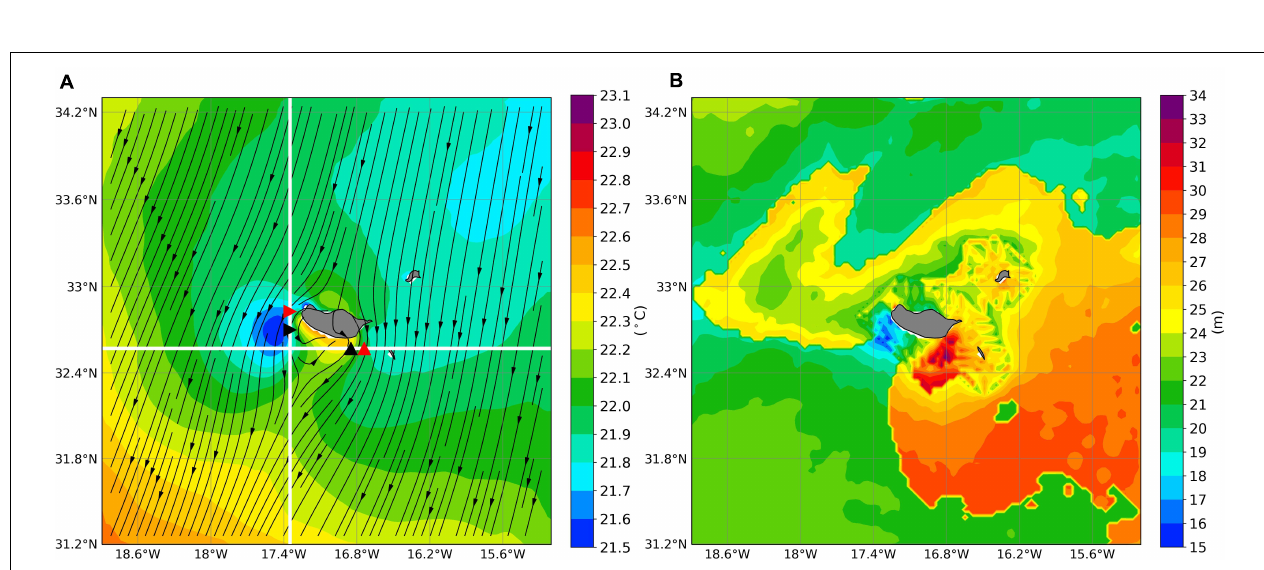
FIGURE 9 | Mean (1983–2017) summer (JJA): (A) sea surface temperature (SST) and (B) Mixed Layer Depth (MLD). White lines in panel (A) indicate Figure 10 cross-sections, black triangles zone of the maximum perturbed ocean in depth and red triangles maximum wind speed, along each section.